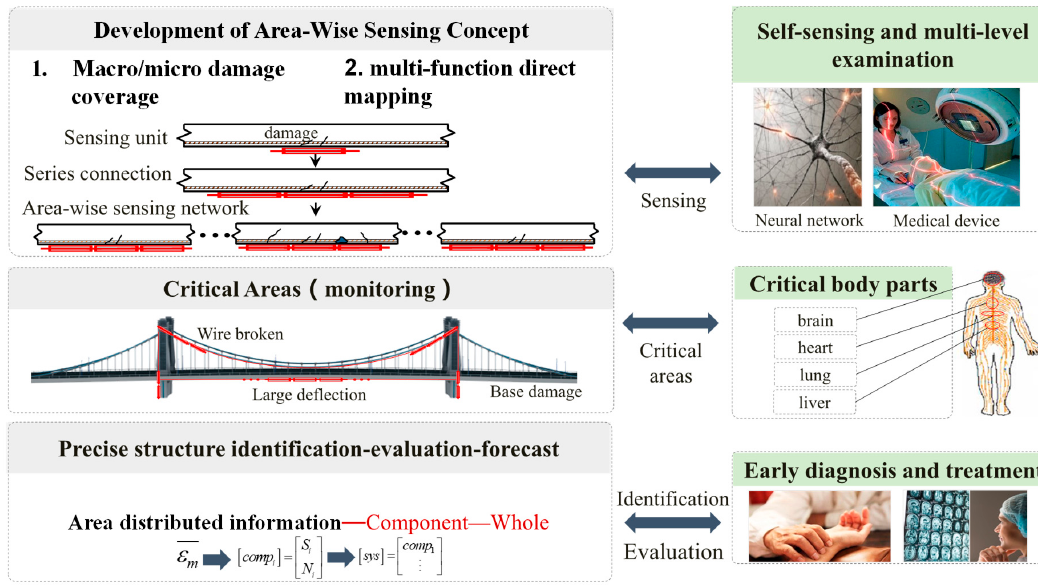
Figure 6. Concept of area-wise distributed sensing and monitoring of a structural system.